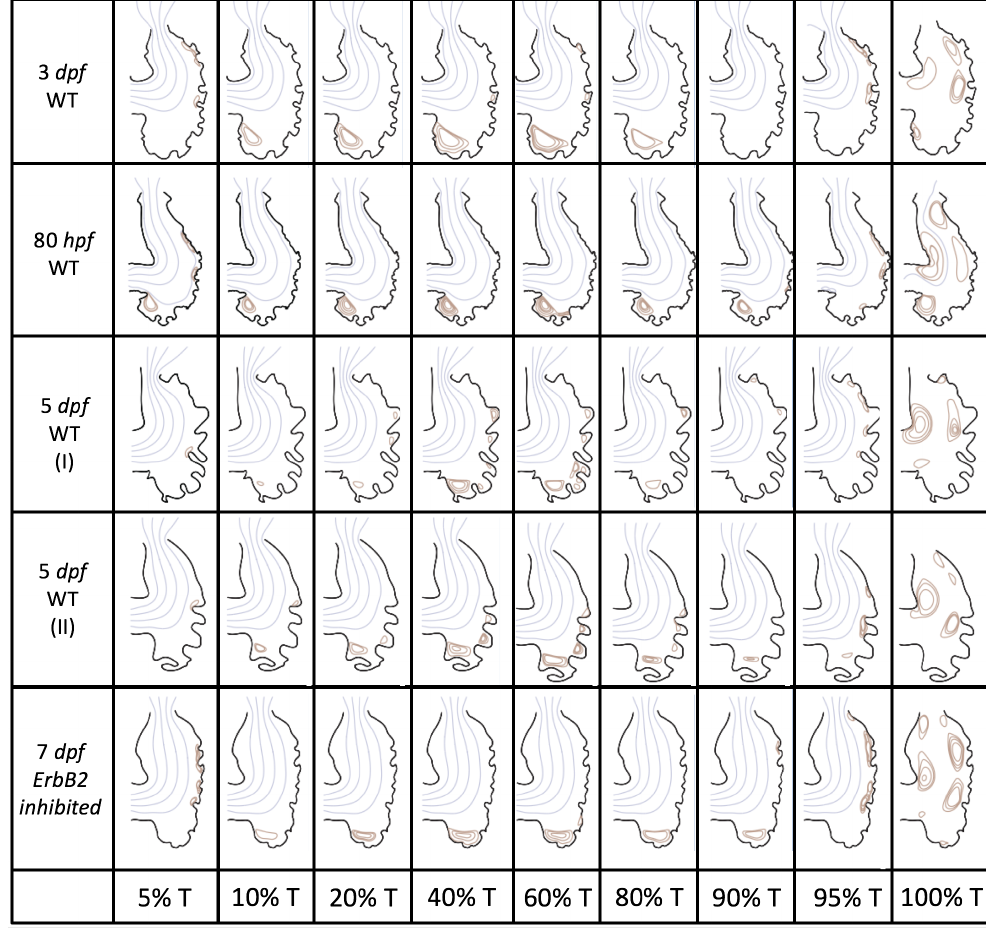
Figure 7. Temporal snapshots of the streamlines at different points during a pulsation cycle, described by a percentage of the pulsation period, T , within the realistic trabeculated ventricles of embryonic zebrafish from different stages of development. These simulations were run for biologically relevant Re , Re =